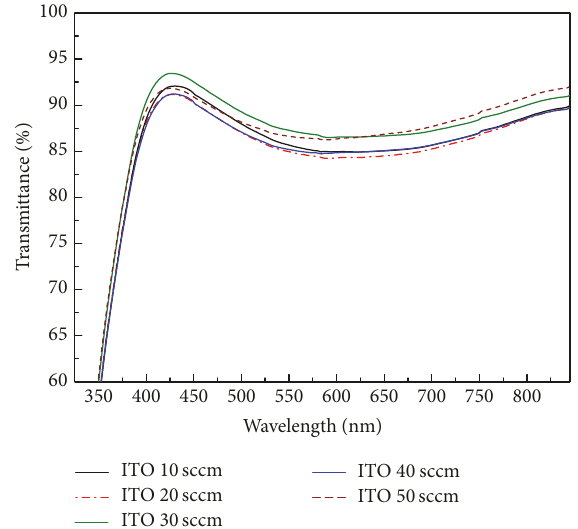
Figure 3: Transmittance spectra of ITO thin films deposited under different oxygen flow rates.